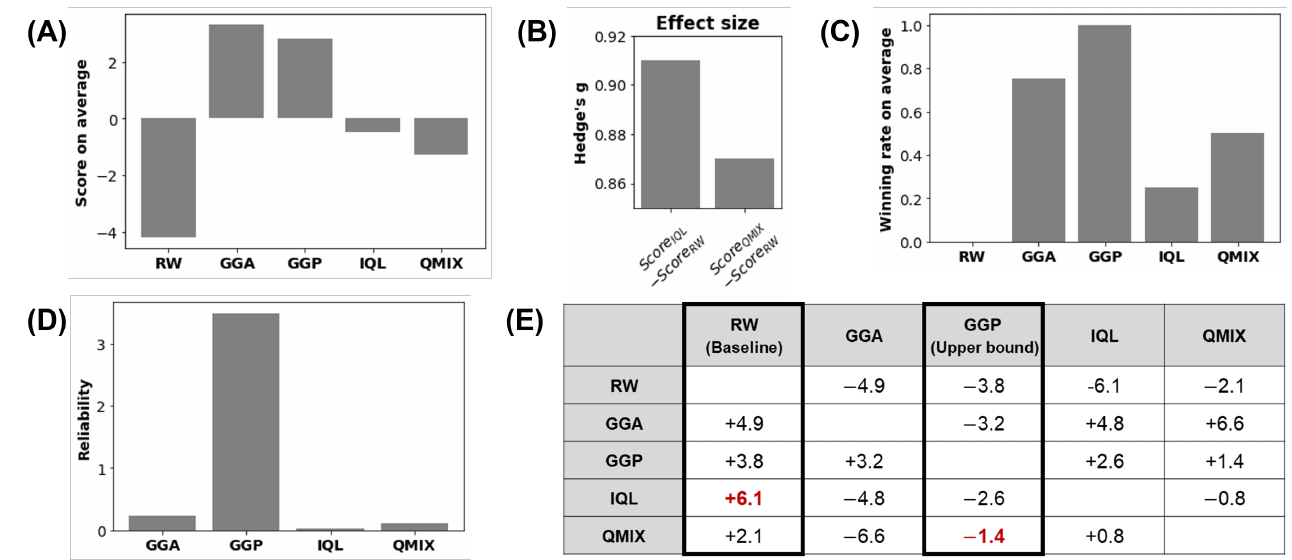
Figure 9. Simulation results: ( A ) Average score. ( B ) Effect size between IQL and RW and between QMIX and RW (Hedge’s g). ( C ) Average winning rate. ( D ) Reliability. ( E ) Simulation results in terms of average scores. The first column refers to the team, and the first row refers to the opponent. A positive number refers to the score with which the team won the game. A negative number refers to the number of points by which the team failed to win the